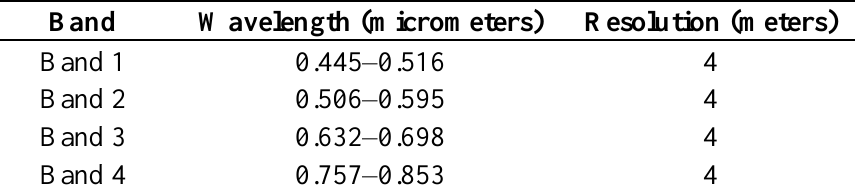
Table 3. IKONOS band designations.